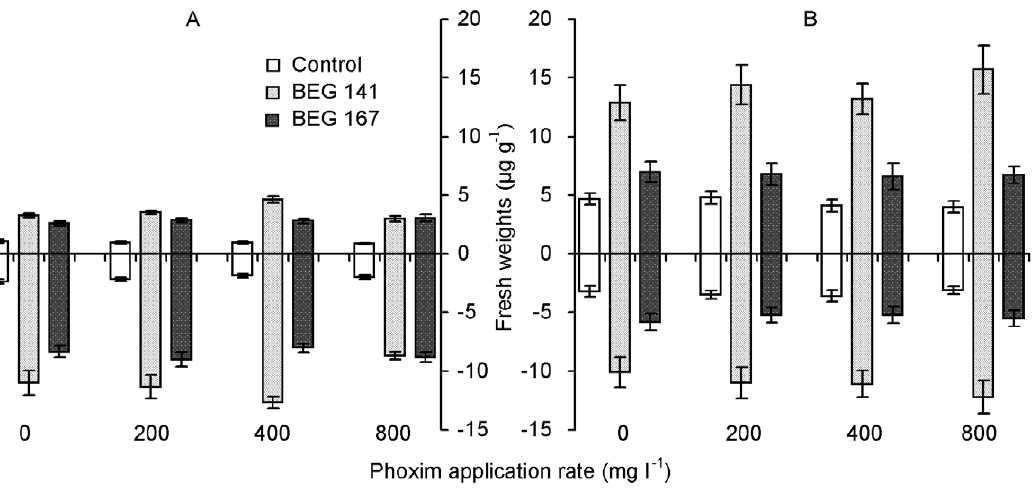
Figure 2. Shoot (above X-axis) and root (below X-axis) fresh weights (means ± SE, n =3) of carrot (A) and green onion (B). Control, BEG 141 and BEG 167: non-AM-inoculation control, G. intraradices BEG 141 and G. mosseae BEG 167, respectively.